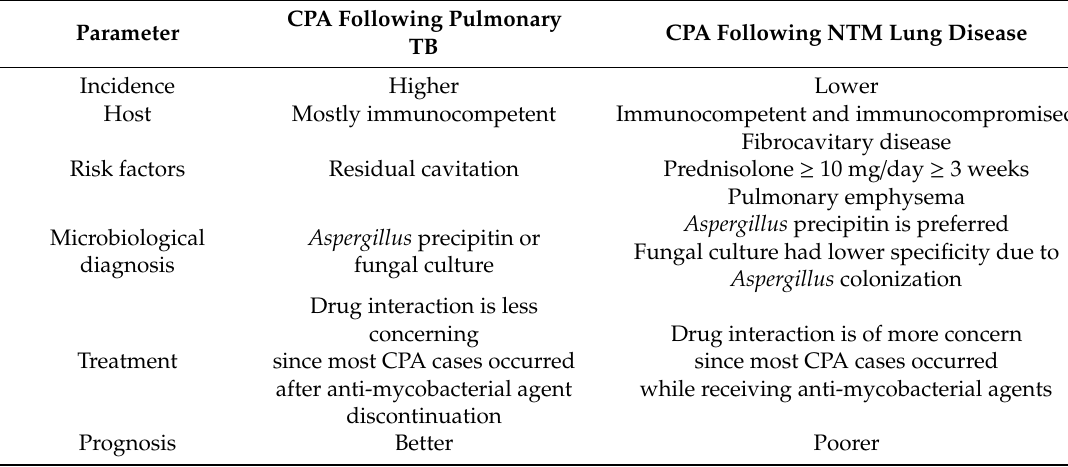
Table 1. Comparison between CPA following pulmonary TB, and CPA following NTM lung